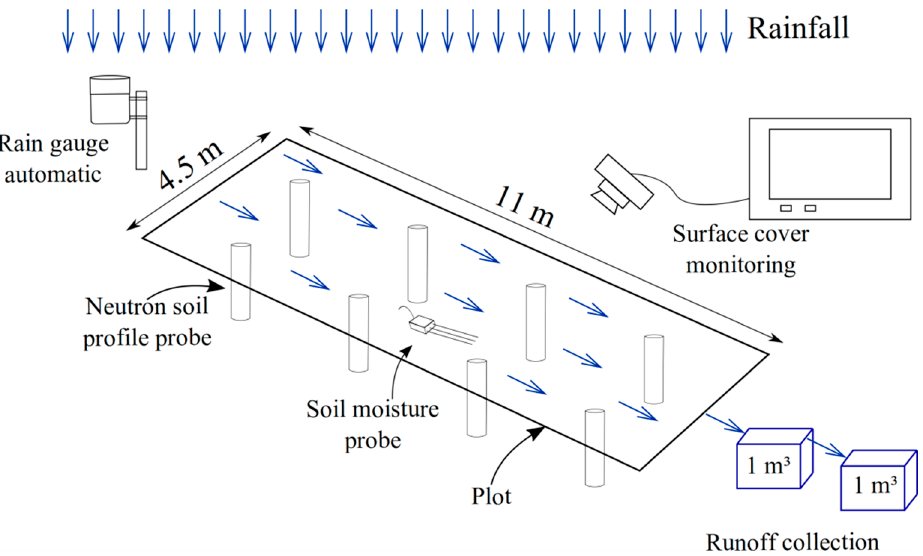
Figure 3. Sketch of the experimental layout.